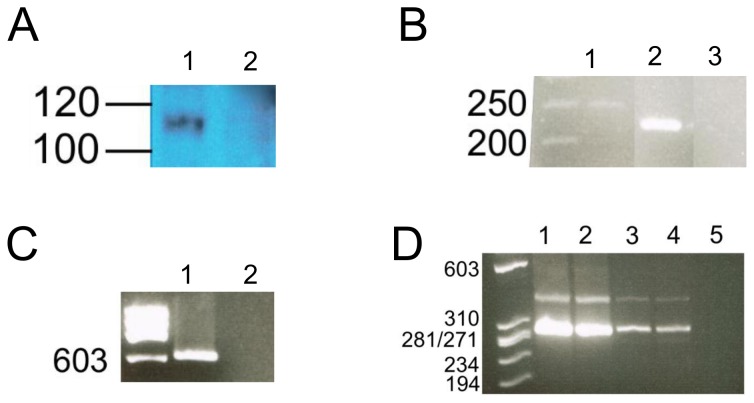
Western blot, ChIP-PCR and competitive RT-PCR.Panel A, Western blotting confirmed the presence of full-length Hltf protein (116-kDa between molecular markers 120 and 100 kDa) in hearts of control mice (lane 1), compared with the absence of protein expression in hearts of Hltf null mice (lane 2). Panel B, electrophoretic resolution of a single population of amplicons from touchdown PCR of ChIP confirmed Hltf bound the transcriptionally active regulatory regions of the promoters of Gata4 (248-bp; lane 1) and Myh7b/miR499 (228-bp; lane 2). Water blank control (lane 3) and molecular ladder (bp) are shown. Panel C, electrophoretic resolution of a single population of amplicons from touchdown PCR of ChIP confirmed Hltf bound the putative promoter of Hif-1a (600-bp, lane 1). Water blank control (lane 2) and φX174 markers are included. Panel D, analysis of competitive RT-PCR products by electrophoresis for the presence/absence of exon 7 in heart (lanes 1-2) and brain (lanes 3-4) revealed the ratio of amplicons without exon 7 (293-bp) to amplicons with exon 7 (390-bp) was the same in the presence (lane 1, 3) and absence (lane 2, 4) of Hltf. The water blank control (lane 5) and φX174 markers are added for completeness. The identity of each population of amplicons was verified by double-stranded sequencing.